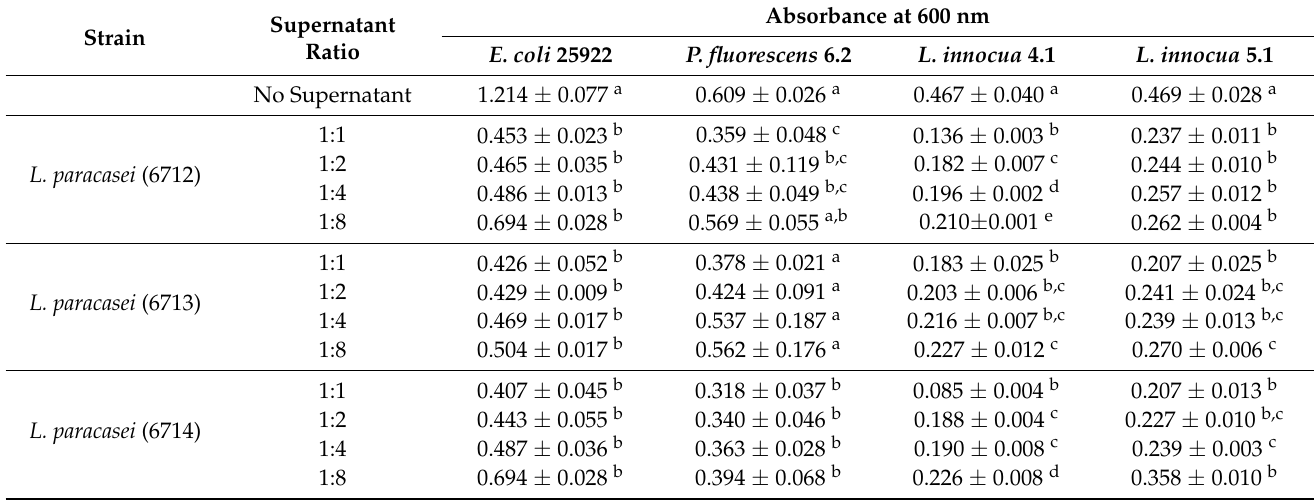
Table 2. Absorbance values at 600 nm obtained for the determination of the antimicrobial activity of the L. paracasei (6712, 6713, and 6714) supernatant against Escherichia coli , Pseudomonas fluorescens , Listeria innocua 4.1, and Listeria innocua